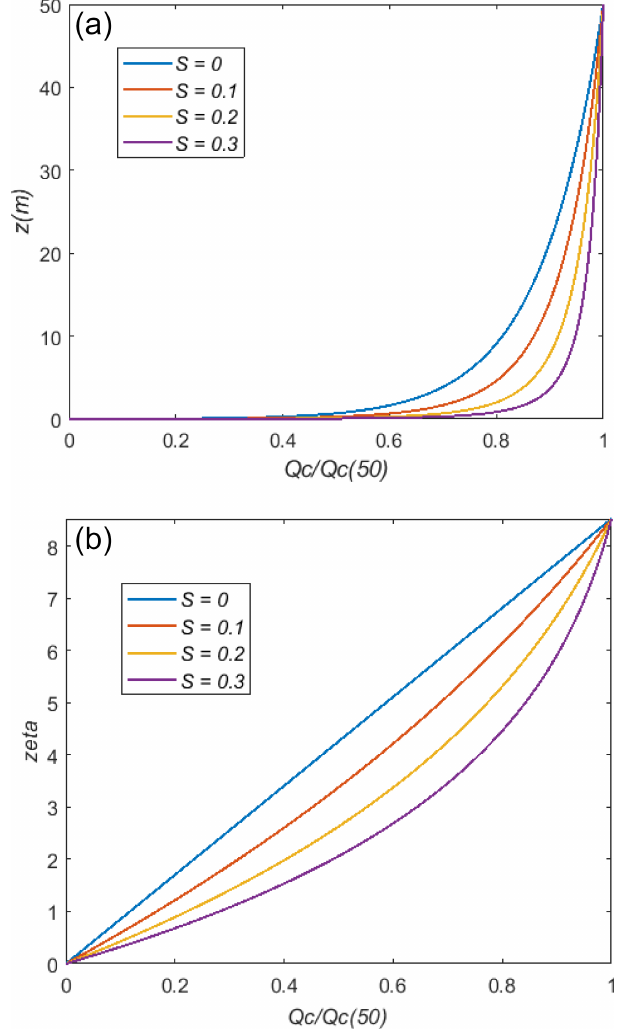
Figure 1. Qc profiles, scaled by the 50m value, from the surface to z = 50m in constant flux layers with gravitational settling. The surface roughness length for aerosol removal z 0c is 0.01m. Plotted with linear (a) and logarithmic (b) height scales and four S